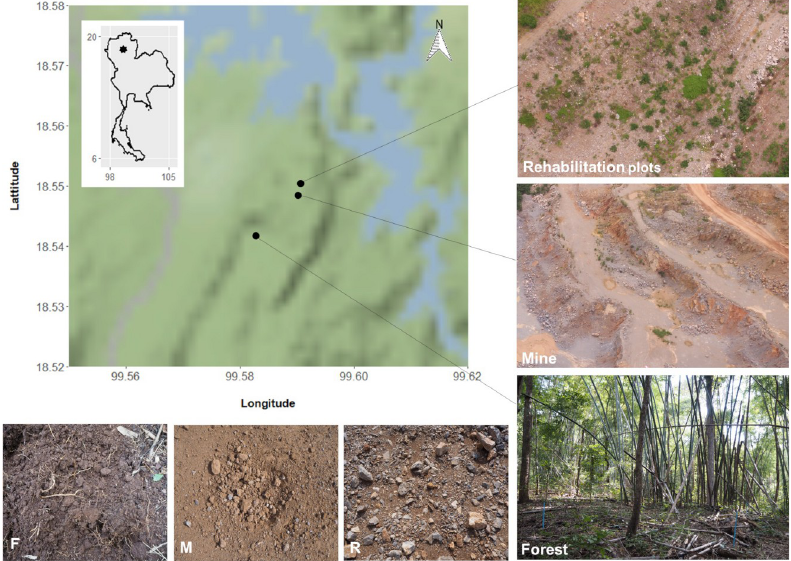
Fig 1. Study sites. Bottom left showing three contrasting soil/substrates from forest (F), mine (M) and young mine- rehabilitation plots (R). Map tiles by Stamen Design, under CC BY 3.0. Data by OpenStreetMap, under ODbL.